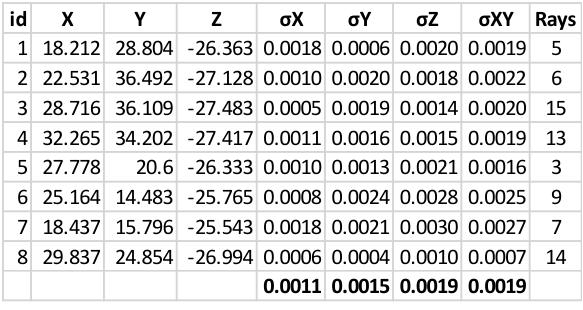
Table 2. Results from photogrammetry. All results in m. After the adjustment, the overall image observation RMS is 0.8 pixels which corresponds to a sigma naught of 0.7 pixels, with a redundancy of ~410K and ~625K observations, for a total of ~72K of 3D tie points plus the 8 signalised points. The average intersecting angle is 26.1 degrees and 41.2 degrees for the 3D tie points and signalised points, respectively. The signalised point with maximum uncertainty is again #7 with σXY 0.03